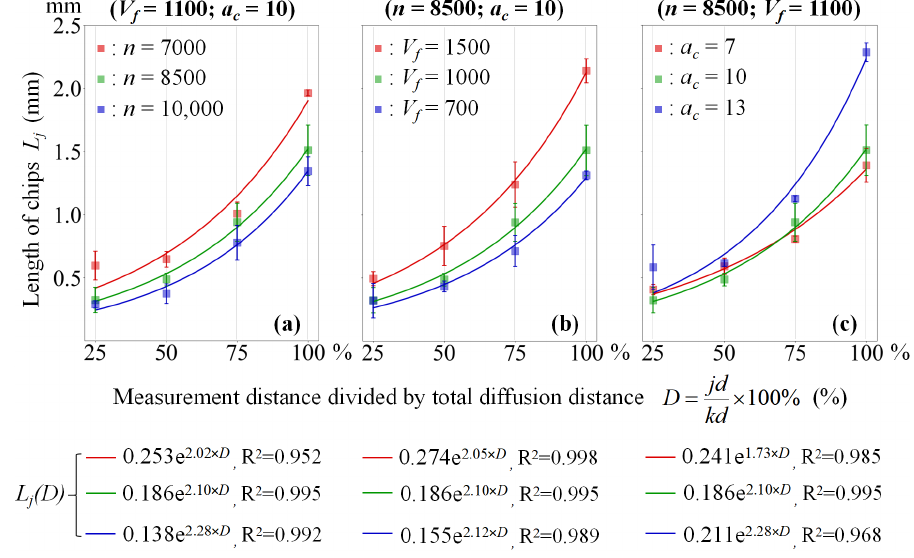
Figure 9. The relationship between sampling relative position D and the sampled chip size L j at different cutting parameters is depicted as L j ( D ), where d represents the sample spacing, j denotes the current sampling sequence, and k represents the total number of samples. The sampling relative position is expressed by (j/k)d × 100% within the range of 0% to 100%. ( a ) The change in L j (D) after changing the spindle speed n when the feed speed V f = 1100 and the depth of cut a c = 10. ( b ) The change in L j (D) after changing the feed rate V f when the spindle speed n = 8500 and the depth of cut a c = 10. ( c ) The change in L j (D) after changing the depth of cut a c at spindle speed n = 8500 and feed rate V f = 1100.